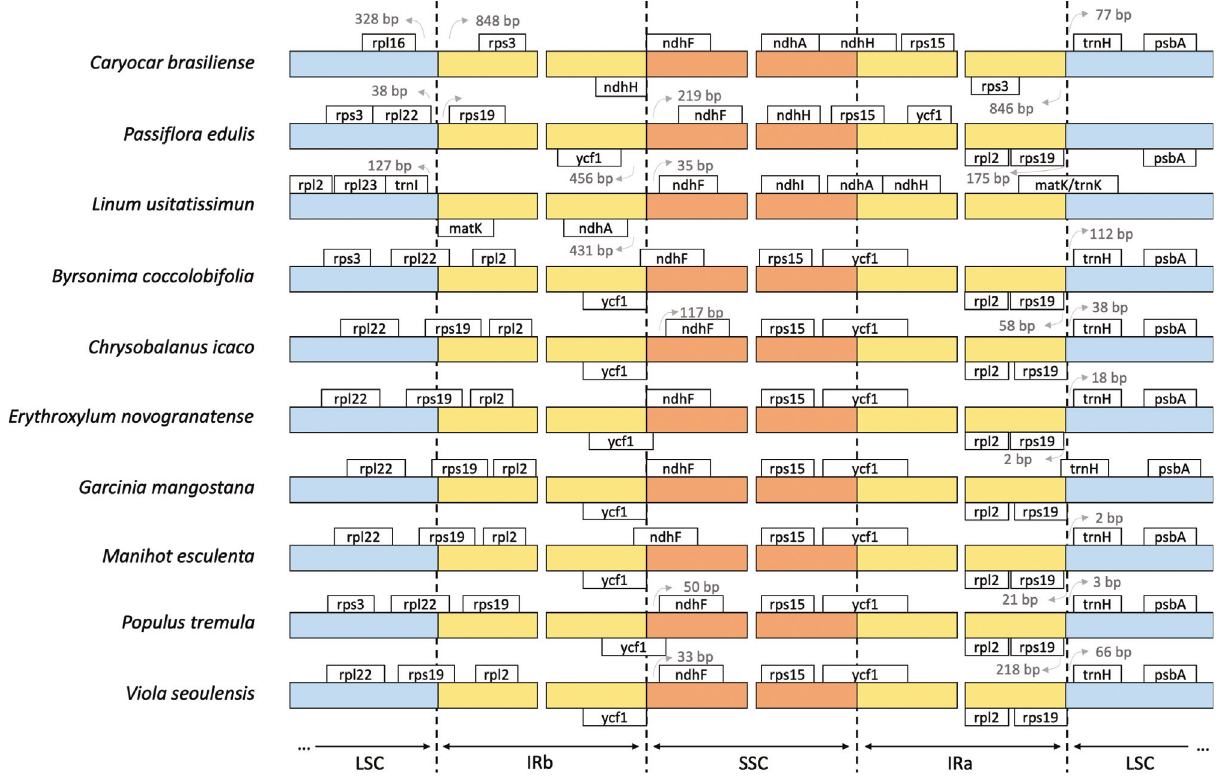
Figure 2 - Comparison of the junctions involving Inverted Repeat (IRa and IRb) regions with Large Single Copy (LSC) and Small Single Copy (SSC) re- gions among 10 chloroplast genomes of Malpighiales. The IR regions are represented in yellow whereas LSC and SSC in blue and orange, respectively. The white boxes represent the genes present in each region. The arrows represent the distance (in base pairs) of genes from the junction site between re-